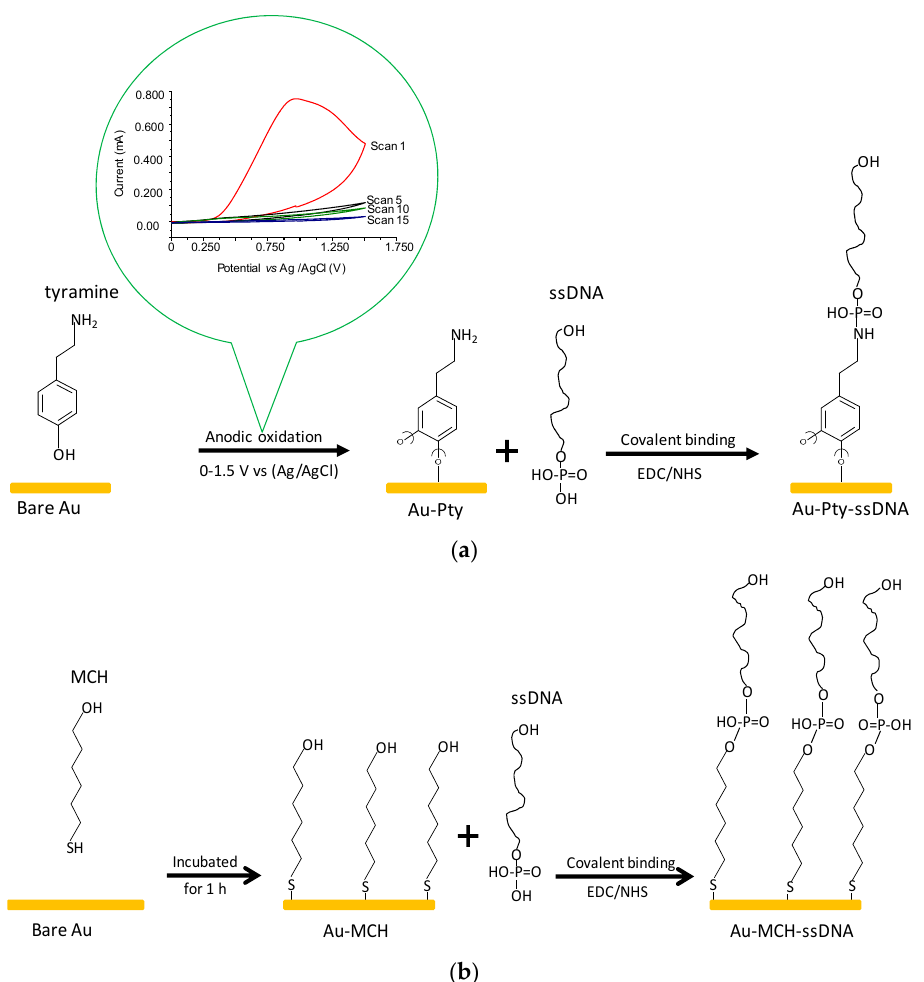
Figure 1. ( a ) Sensor chip surface modified with Pty film and followed by addition of ssDNA to form phosphoramide ester bond. The inset shows the reduction in anodic peak current during electropolymerization of tyramine on the sensor chip surface (scan numbers 1, 5, 10 and 15). ( b ) Sensor chip surface modified with MCH-SAM and followed by addition of ssDNA to form phosphate ester bond.